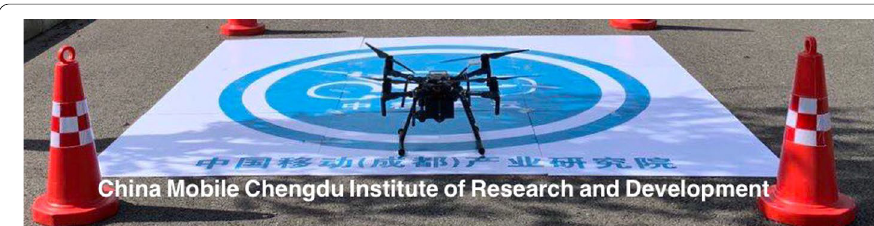
Fig. 4 DJI M210 UAV equipped with a 5G communication module provided by China Mobile Chengdu Institute of Research and